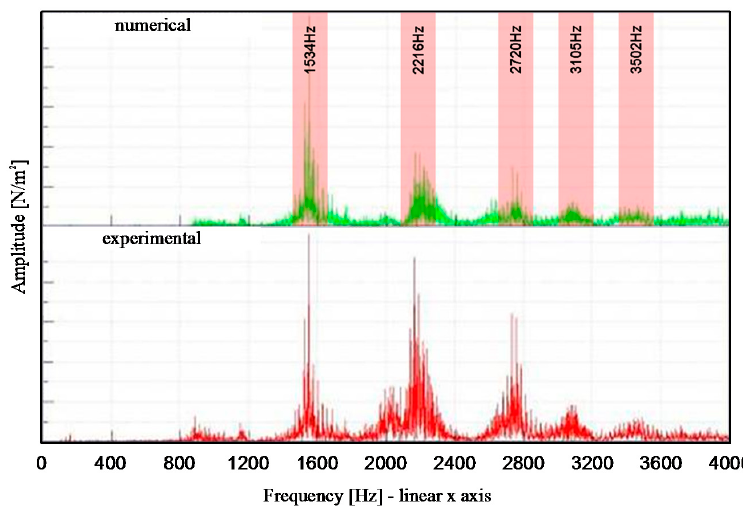
Figure 9. Narrow-band numerical ( up ) and experimental ( down ) comparison of the sound pressure magnitude.